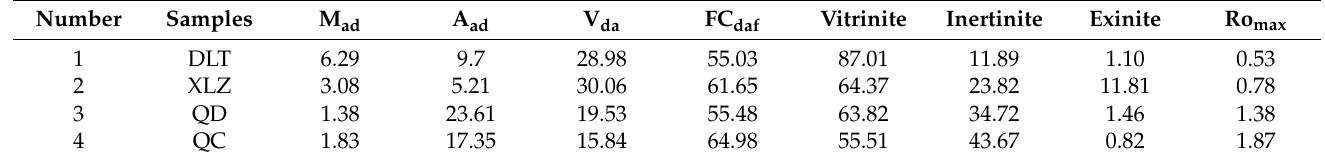
Table 1. The industrial